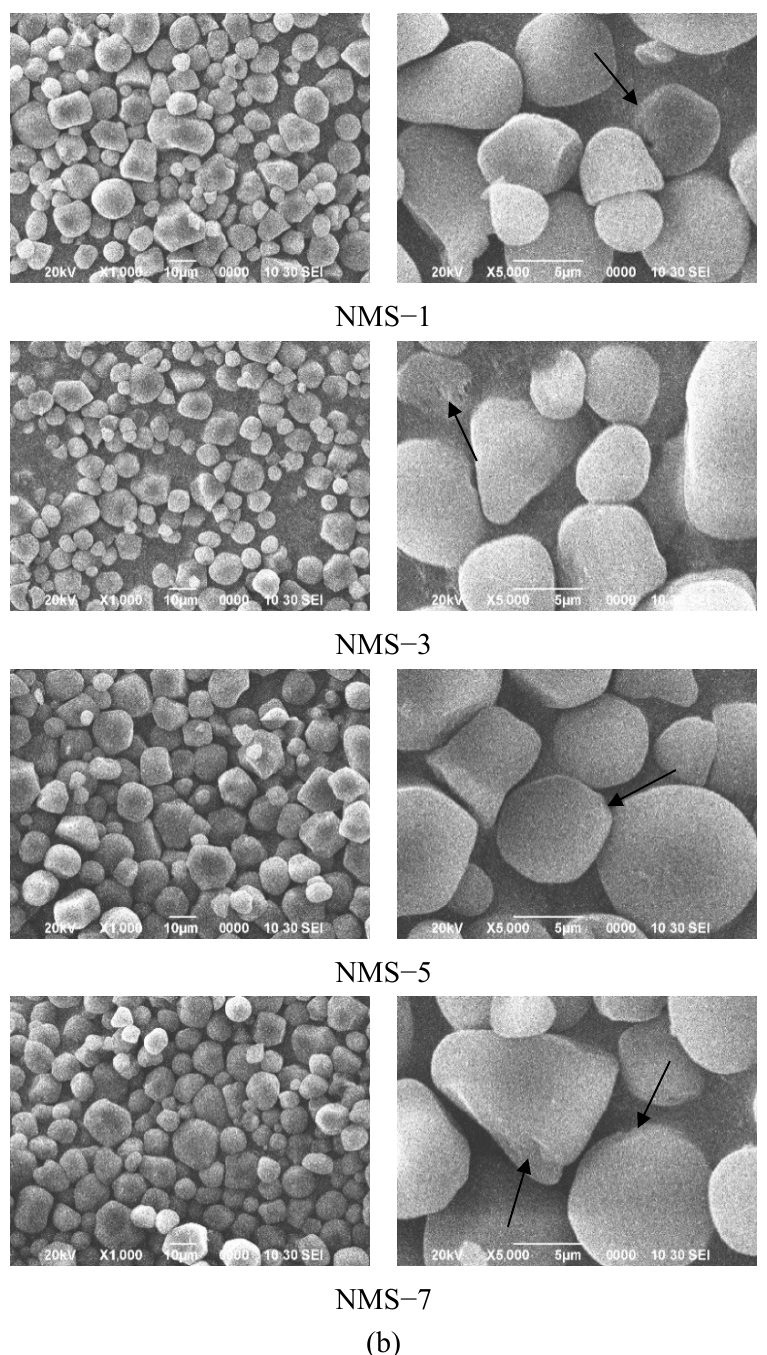
Figure 2. SEM images of maize starch granules treated by APPJ. ( a ) Waxy maize starch ( b ), normal maize starch.